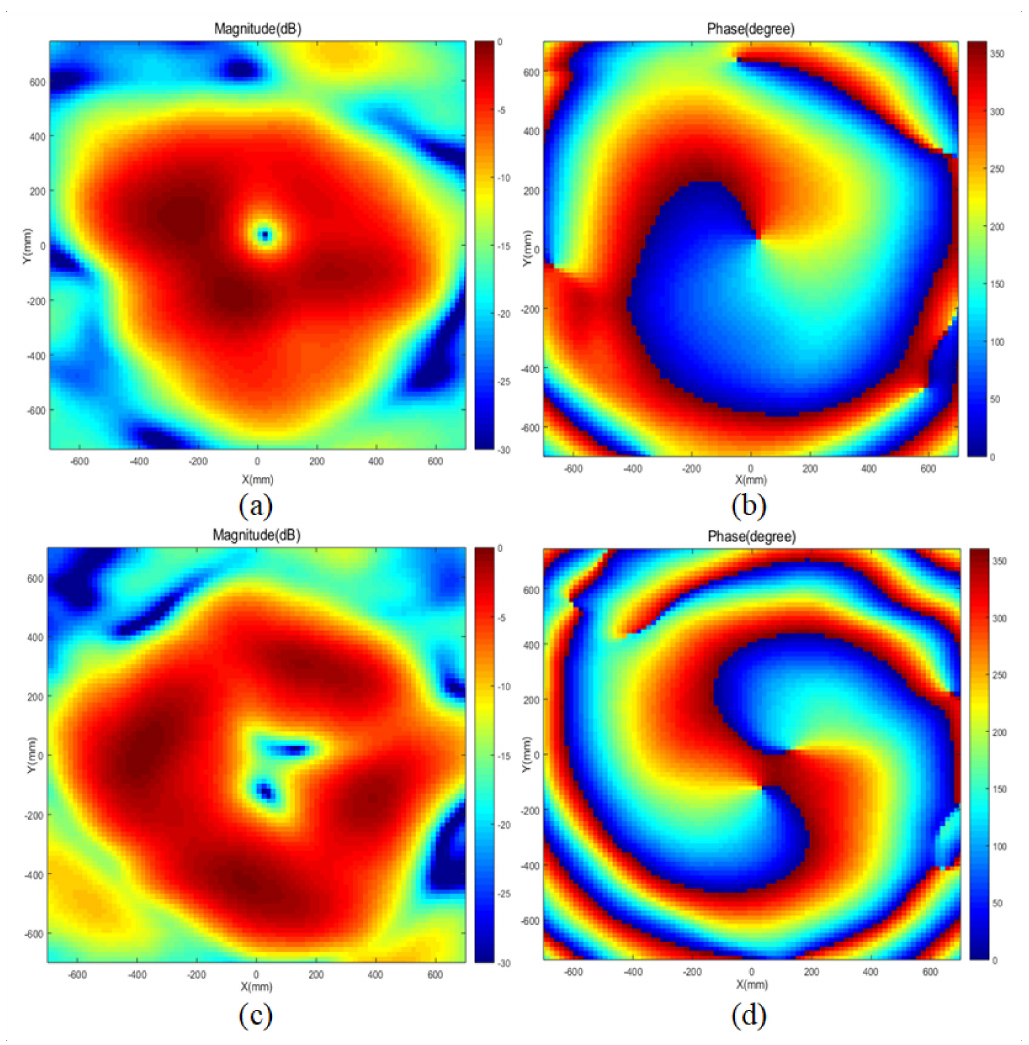
Figure 5. Measured near-field data of OAM wave: ( a ) magnitude distribution for l = 1; ( b ) phase distribution for l = 1; ( c ) magnitude distribution for l = 2; ( d ) phase distribution for l =